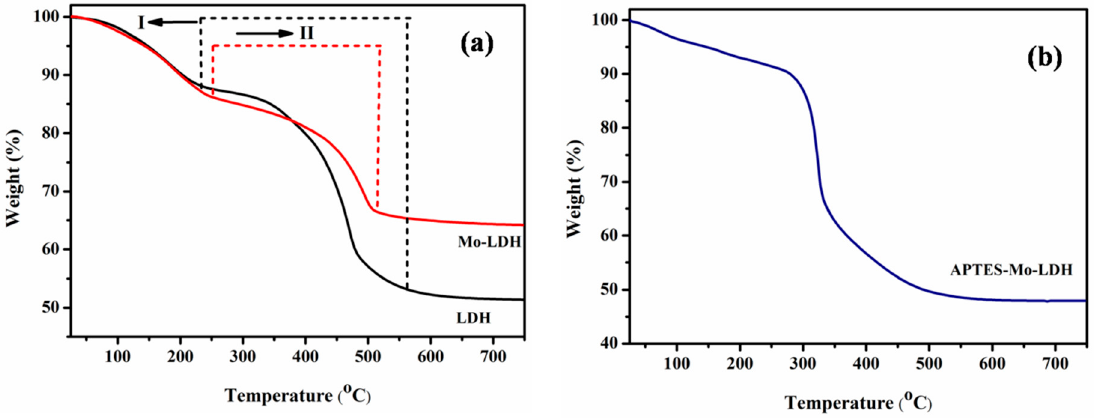
Figure 3. ( a , b ) Thermogravimetric analysis (TGA) thermogram of LDH, Mo–LDH, and APTES–Mo–LDH.